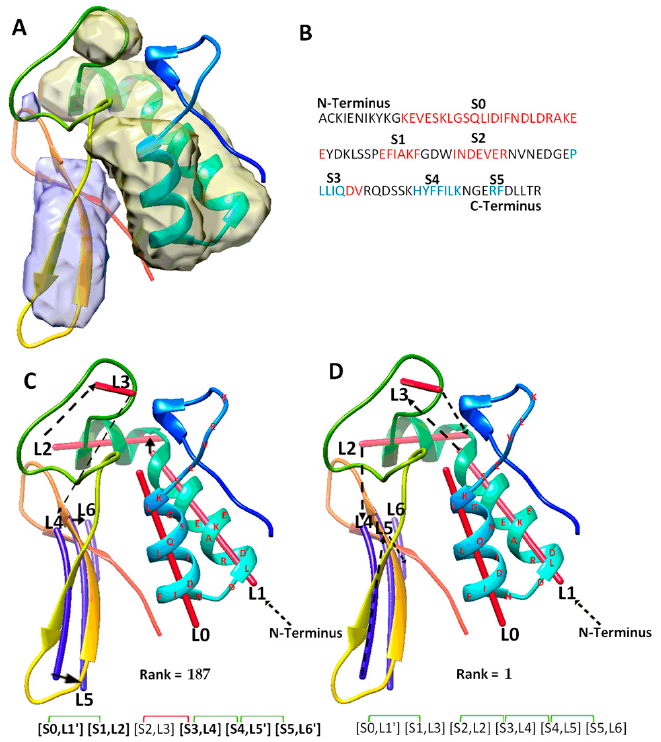
Figure 4. The maximum-match topology for case T1031. ( A ) The atomic structure (rainbow ribbon) is superimposed with the secondary structure regions of α -helices (yellow density) and β -sheet (blue density) detected using DeepSSETracer [20]. ( B ) The amino acid sequence and secondary structures, helices (red) and β -strands (blue), predicted using JPred [30]. ( C ) The 187th ranked initial topology is indicated with black arrows, α -traces (red lines) and β -traces (blue lines) from N to C terminal of the protein sequence. Correctly mapped secondary structure pairs are highlighted in the representation of the maximum-match topology. Secondary structure contact pairs are marked with green and red for satisfaction and dissatisfactory respectively. ( D ) The 1st ranked topology shown similarly as in ( C